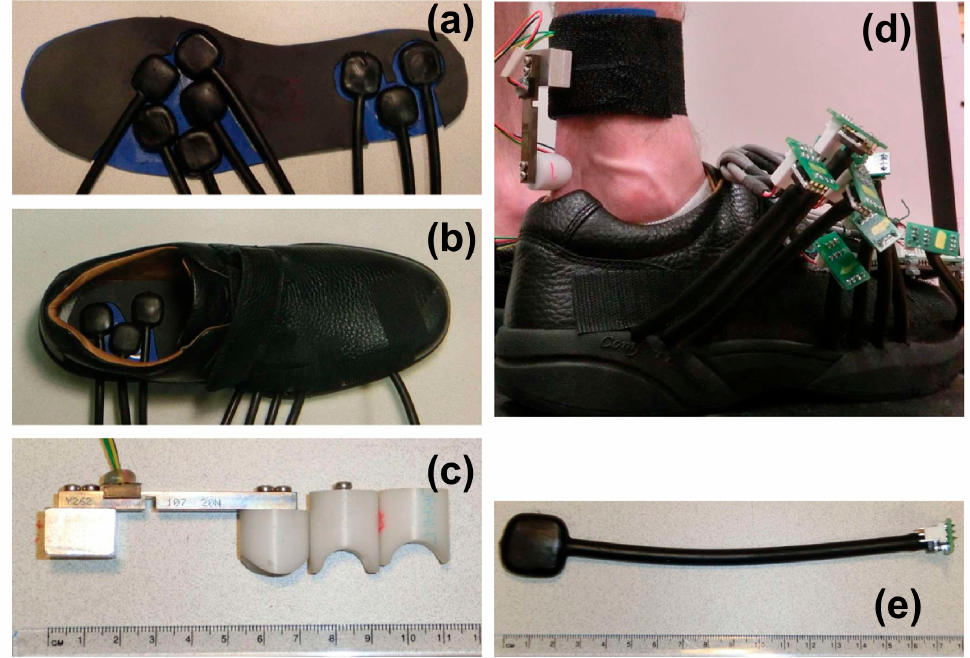
Figure 15. Instrumented shoe developed by Jacobs and Ferris [77].